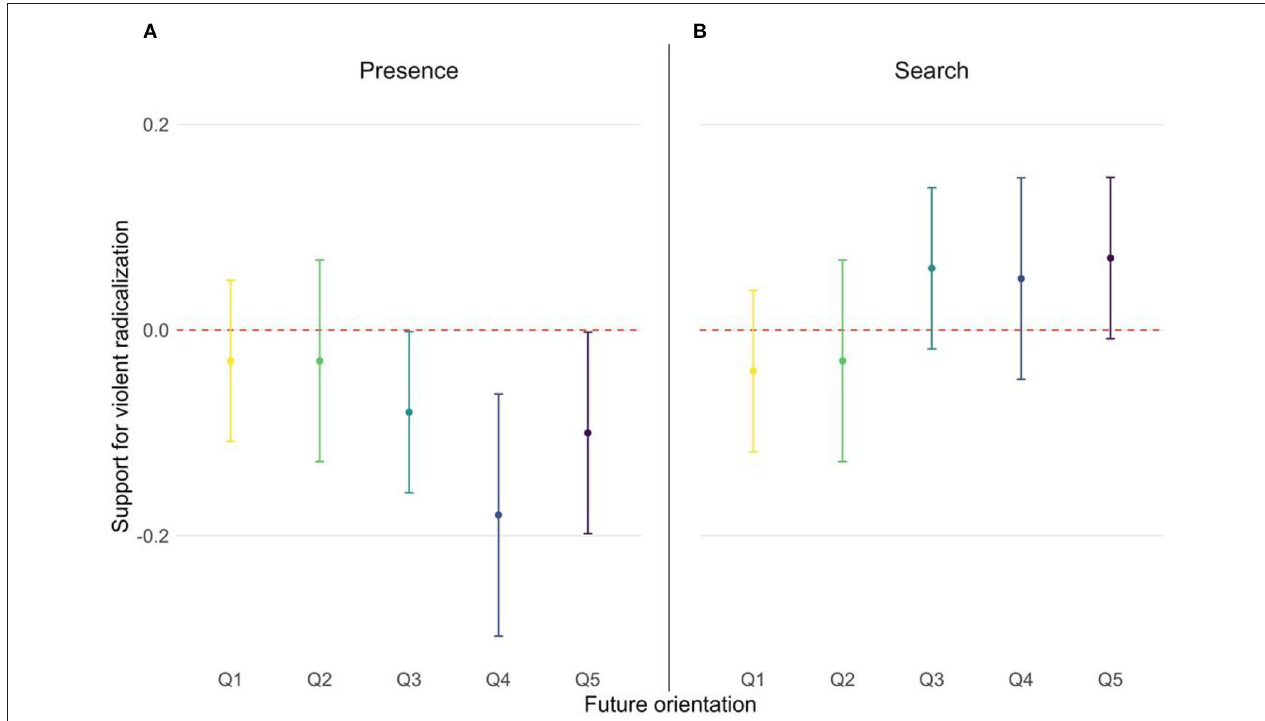
FIGURE 1 | Associations between presence of meaning in life (A) and search for meaning in life (B) and support for violent radicalization, stratified by levels of future orientation, in the overall sample ( n = 3,100). All models presented included relevant sociodemographic variables as covariates. Q1 represents low future orientation scores. See the online article for the color version of this